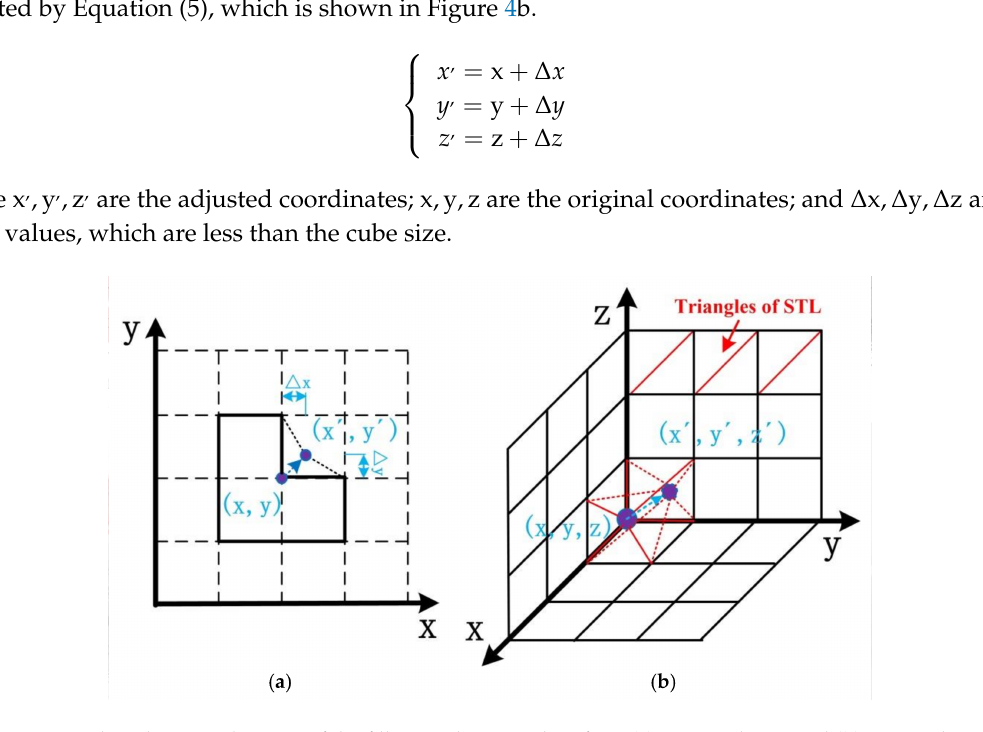
Figure 4. The schematic diagram of the fillet rough external surface: ( a ) groove shape; and ( b ) corner shape.